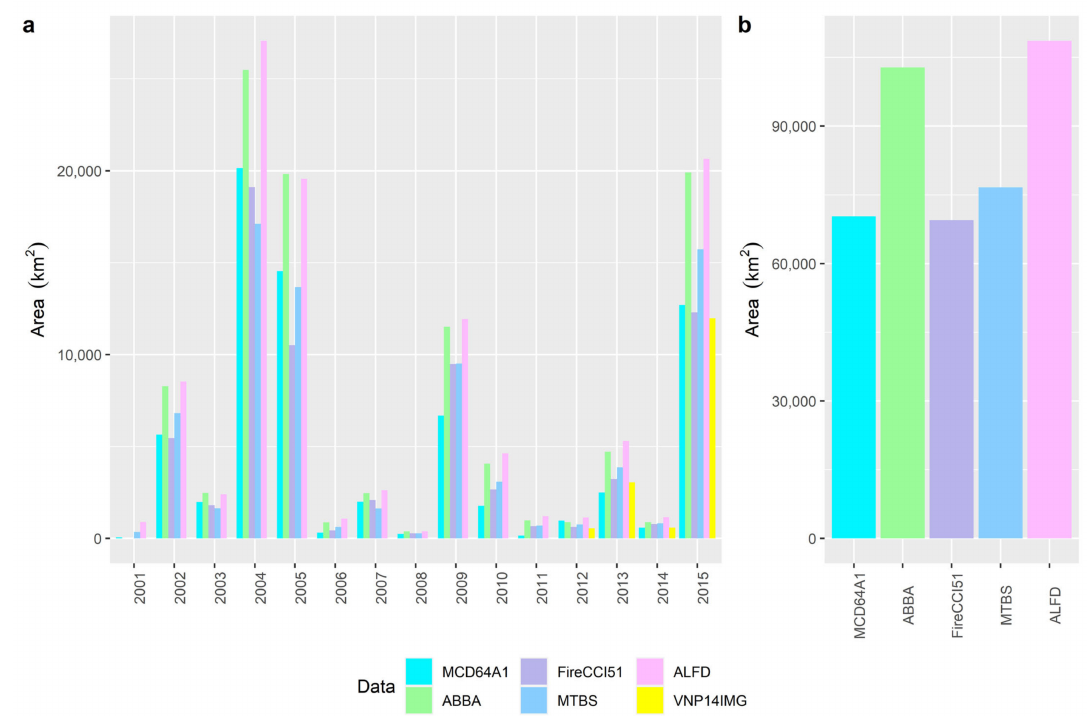
Figure 2. Comparisons of ( a ) annual total area and ( b ) grand total area of burned areas as mapped by the MCD64A1, ABBA, FireCCI51, MTBS, ALFD, and VNP14IMG data over areas in Alaska north of 60 ◦ N. The grand total area of burned areas as mapped by VNP14IMG is not visualized in ( b ) because of its shorter temporal coverage.